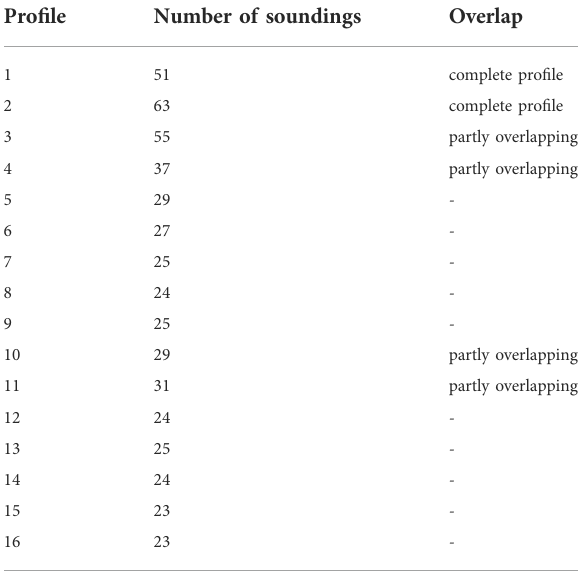
TABLE 2 Number of TEM soundings in each pro fi le (with pro fi le 1 starting in the south) and indication if overlapping measurements were performed (i.e., subsequent TEM loops